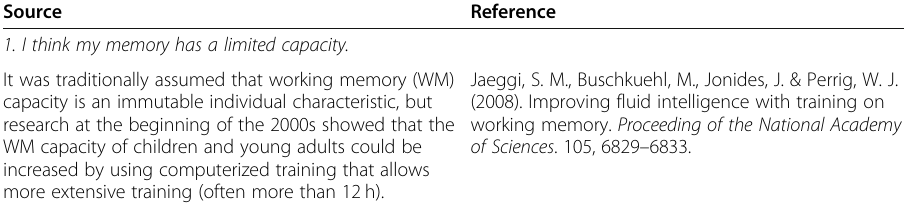
Table 3 Memory factual knowledge; exemplar item with the source and